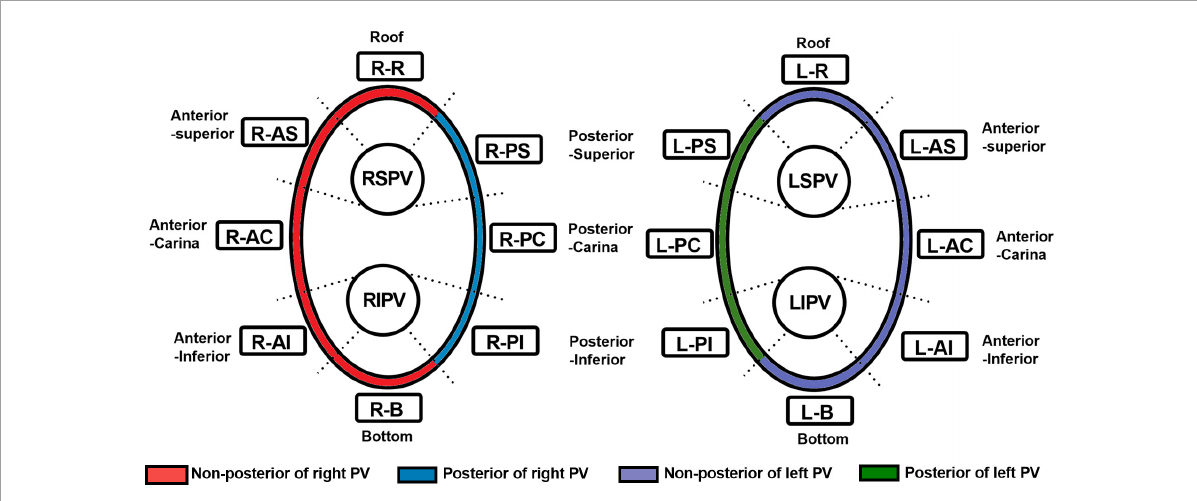
FIGURE3 Segmentation of the pulmonary vein. RSPV, right superior pulmonary vein; RIPV, right inferior pulmonary vein; LSPV, left superior pulmonary vein; LIPV, left inferior pulmonary vein; R-R, right roof; R-AS, right anterior superior; R-AC, right anterior carina; R-AI, right anterior inferior; R-B, right bottom; R-PI, right posterior inferior; R-PC, right posterior carina; R-PS, right posterior superior; L-R, left roof; L-AS, left anterior superior; L-AC, left anterior carina; L-AI, left anterior inferior; L-B, left bottom; L-PI, left posterior inferior; L-PC, left posterior carina; L-PS, left posterior superior; PV, pulmonary vein.